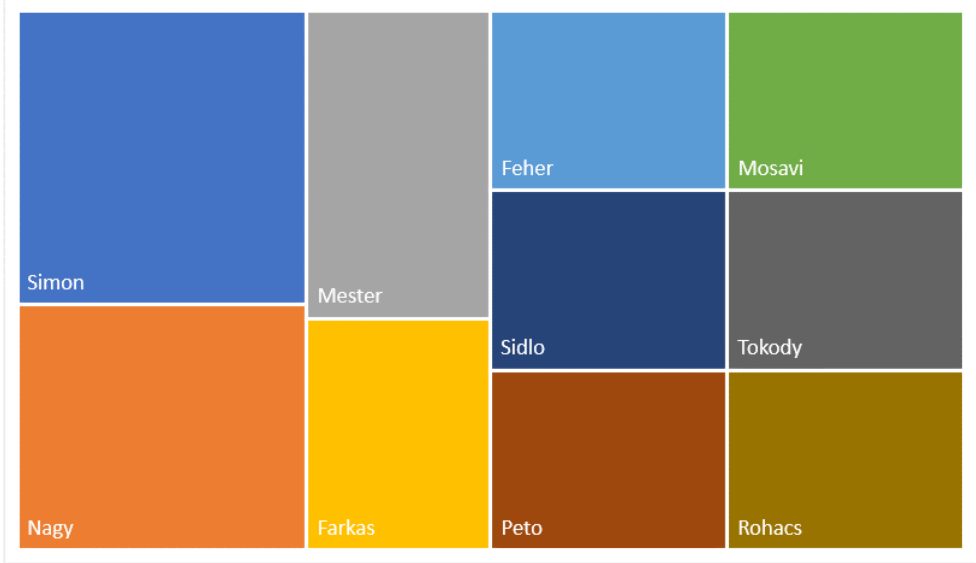
Figure 15. An overview of Hungarian authors publishing on the topic of Smart cities. Source: own analysis as per Web of Science (2022).